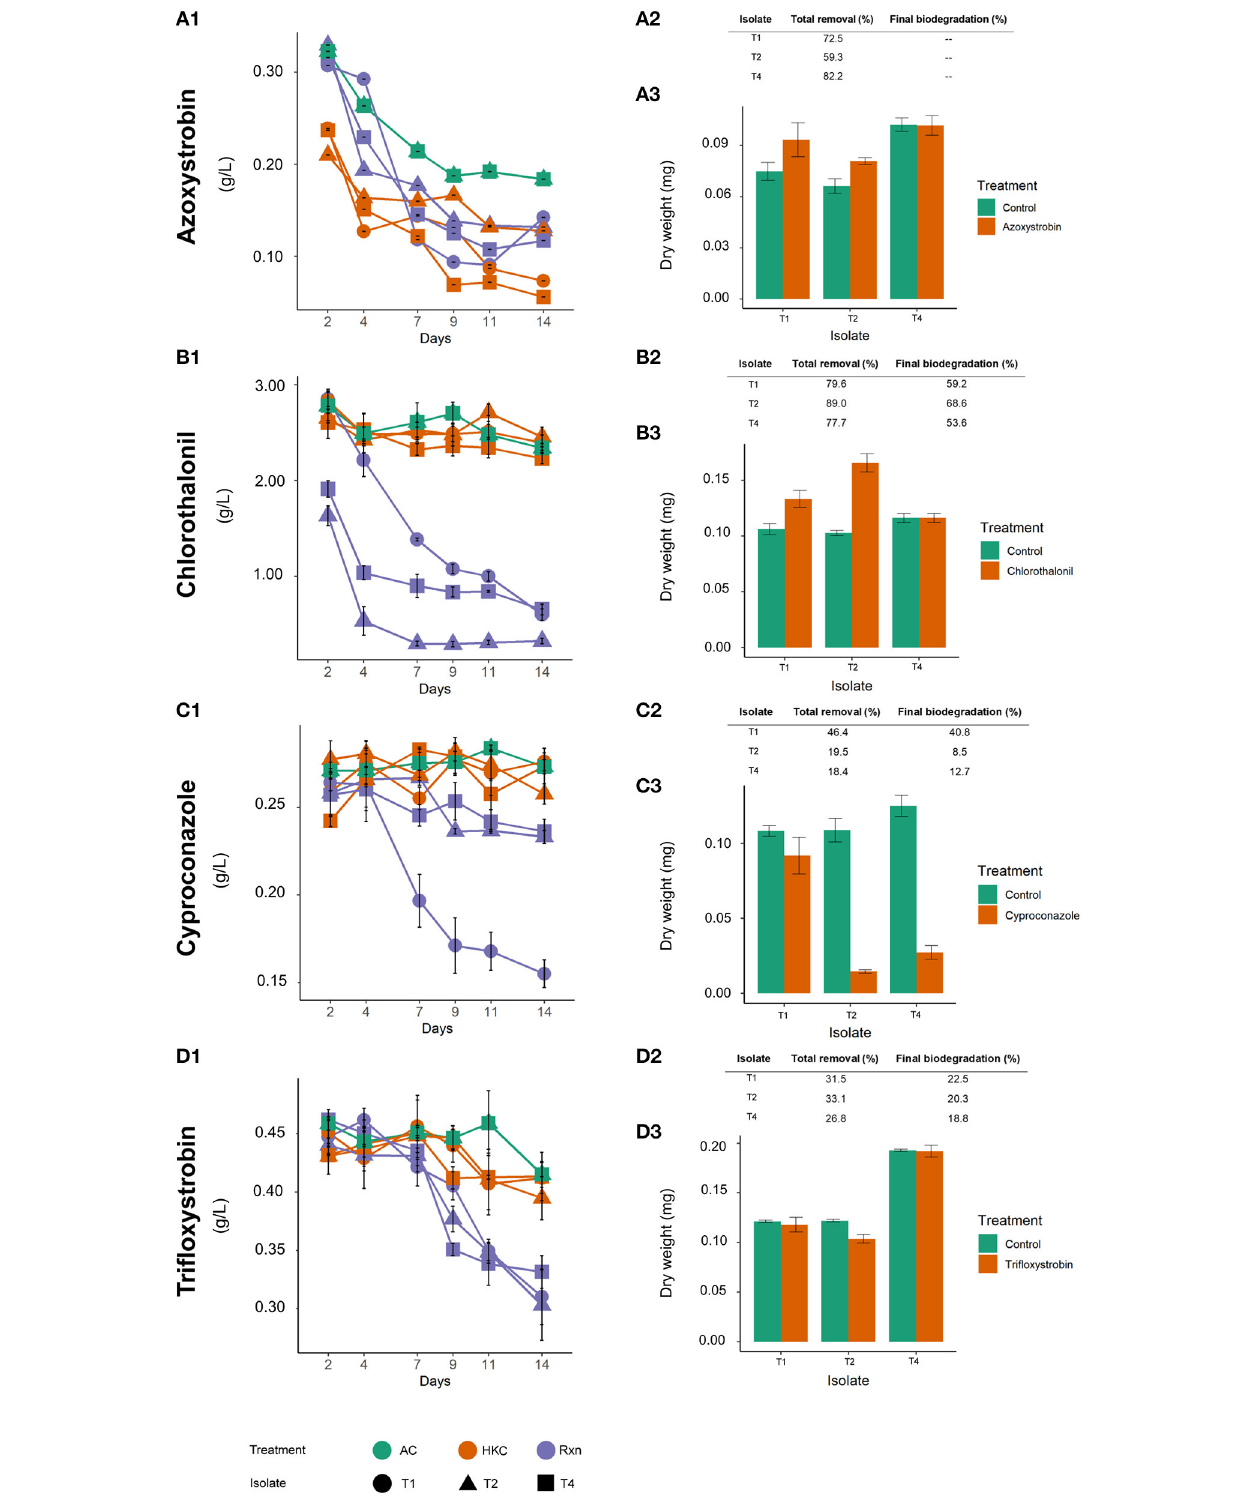
FIGURE 3 | Fungicide removal profiles and final fungal dry weight of Trichoderma in the presence of azoxystrobin (A) , chlorothalonil (B) , cyproconazole (C) , and trifloxystrobin (D) . AC, Abiotic control; HKC, Heat-killed control; Rxn, viable fungal biomass treatment. In (A1–D1) , numbers in Y axis (g/L) refer to concentration of active